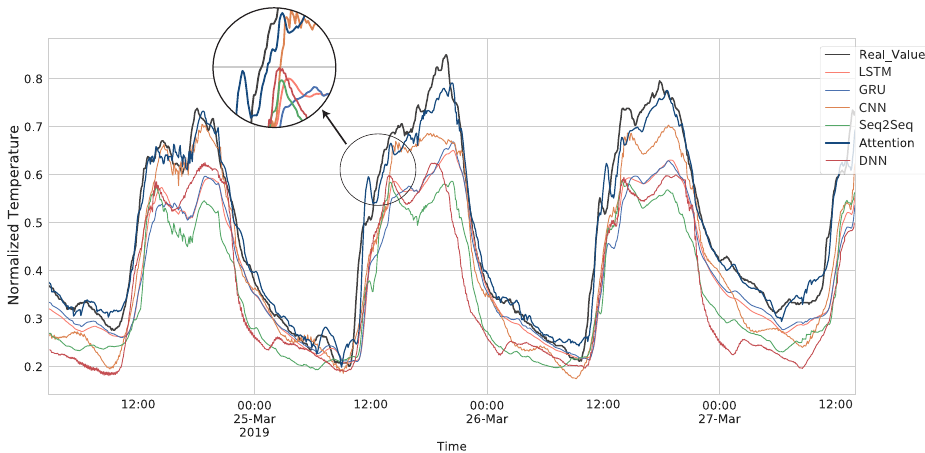
Figure 15. Comparison of models predictions with real